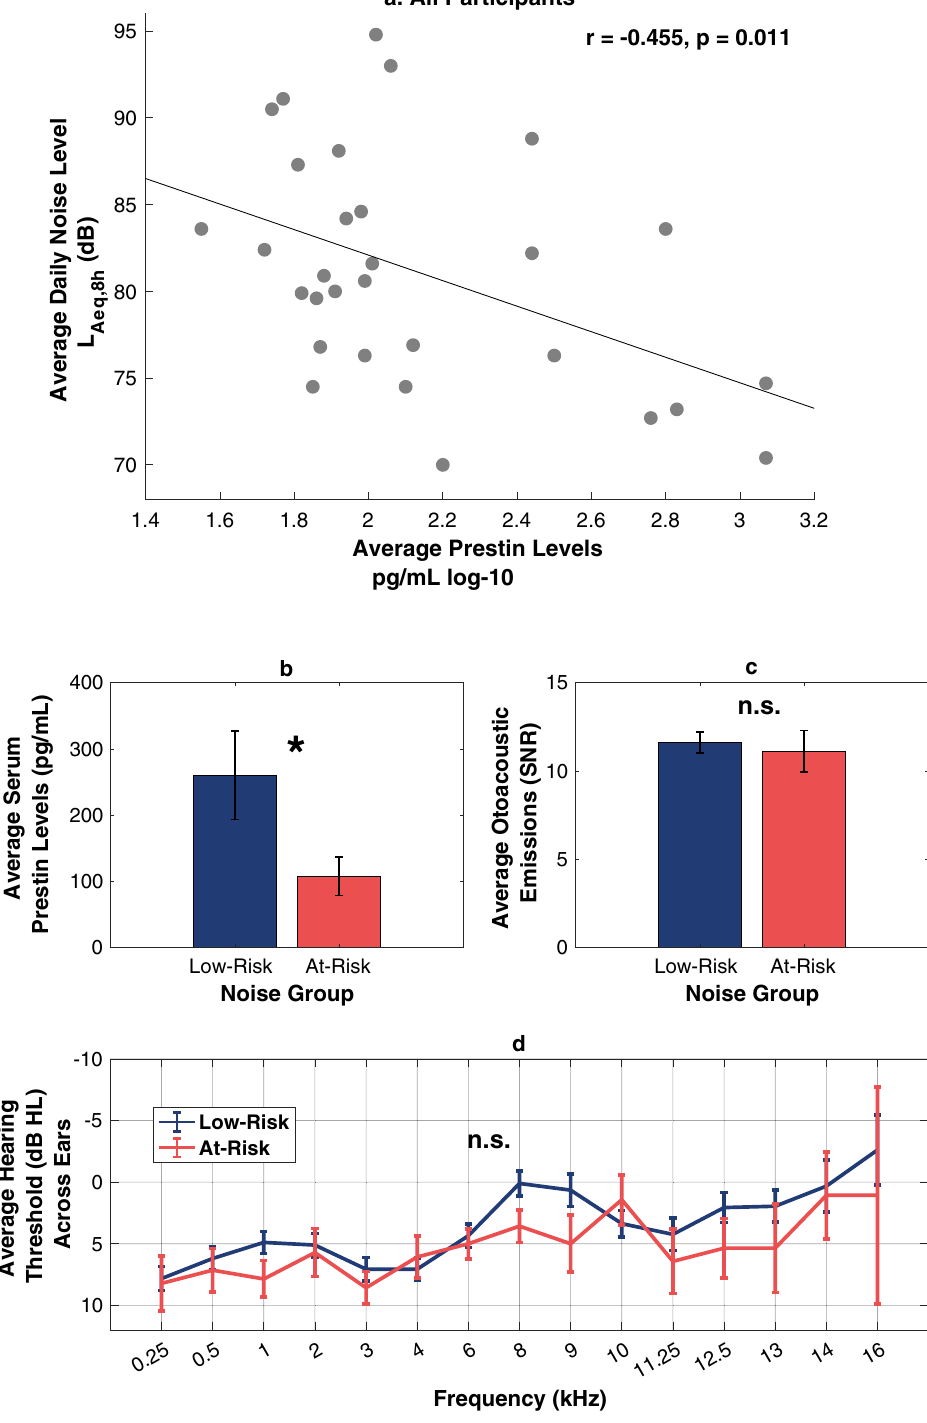
Figure 4. Serum prestin and noise levels across all participants, and separated by noise groups. ( a ) Average daily noise exposure level and average prestin levels show a negative relation, where individuals with higher levels of noise exposure have lower levels of serum prestin. This correlation aligns with the predictions of both the Hidden Outer Hair Cell Damage Hypothesis and the Environmental Downregulation Hypothesis. ( b ) Low- risk (< 100 dose %) and at-risk (> 100 dose %) noise groups differ significantly in average serum prestin levels, but not in average otoacoustic emissions signal-to-noise ratio (SNR) ( c ) or standard or extended high frequency (EHF) pure tone averages (PTA) ( d ). Error bars represent the standard error of the mean. *Significant at the p < 0.05 level; n.s. = not significant at the p < 0.05